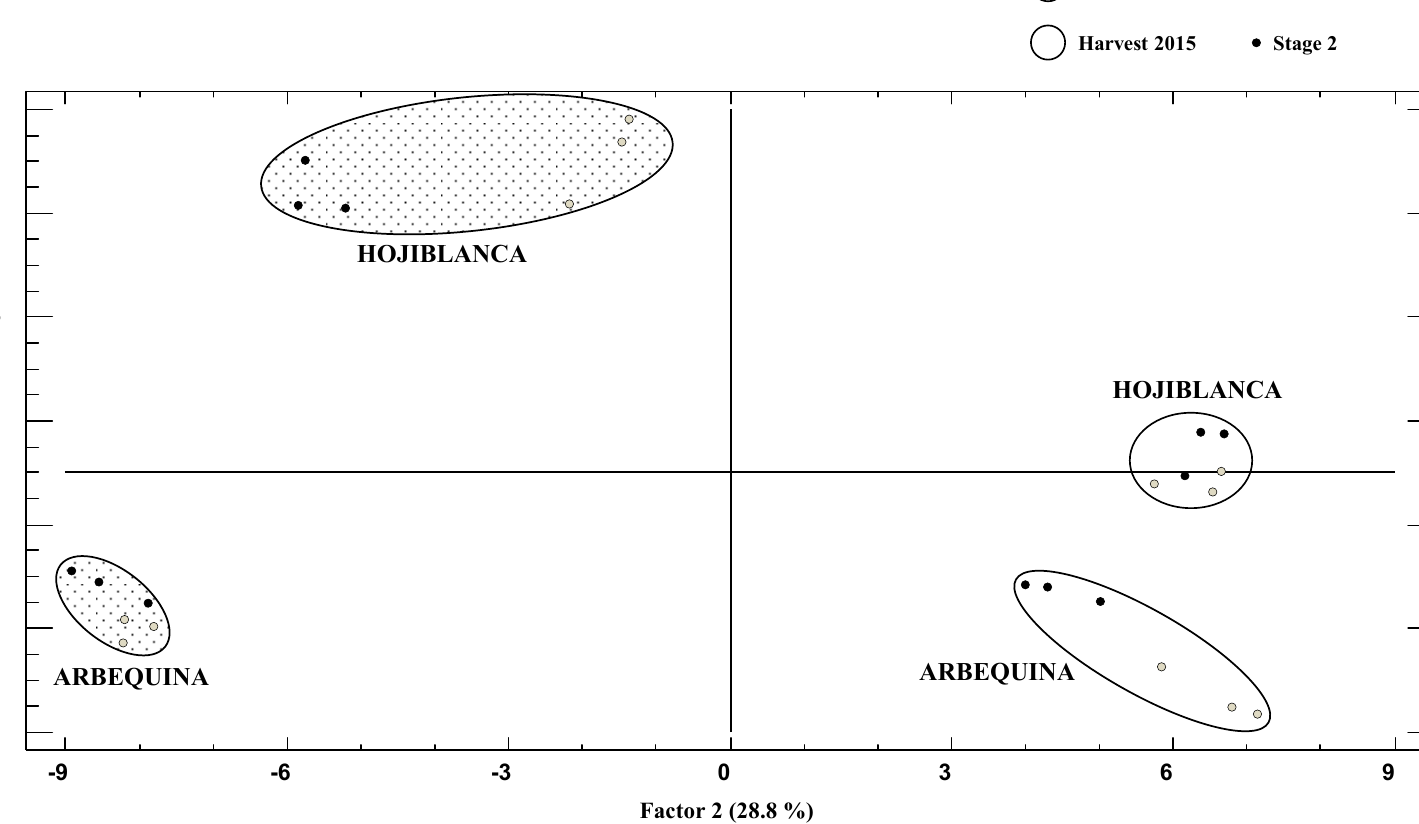
Figure 4. Factor analysis score graph of the two main factors (Factor 1 vs. Factor 2), considering all the variables analyzed in the EVOO from different cultivars, years and crop stage ( n = 24).